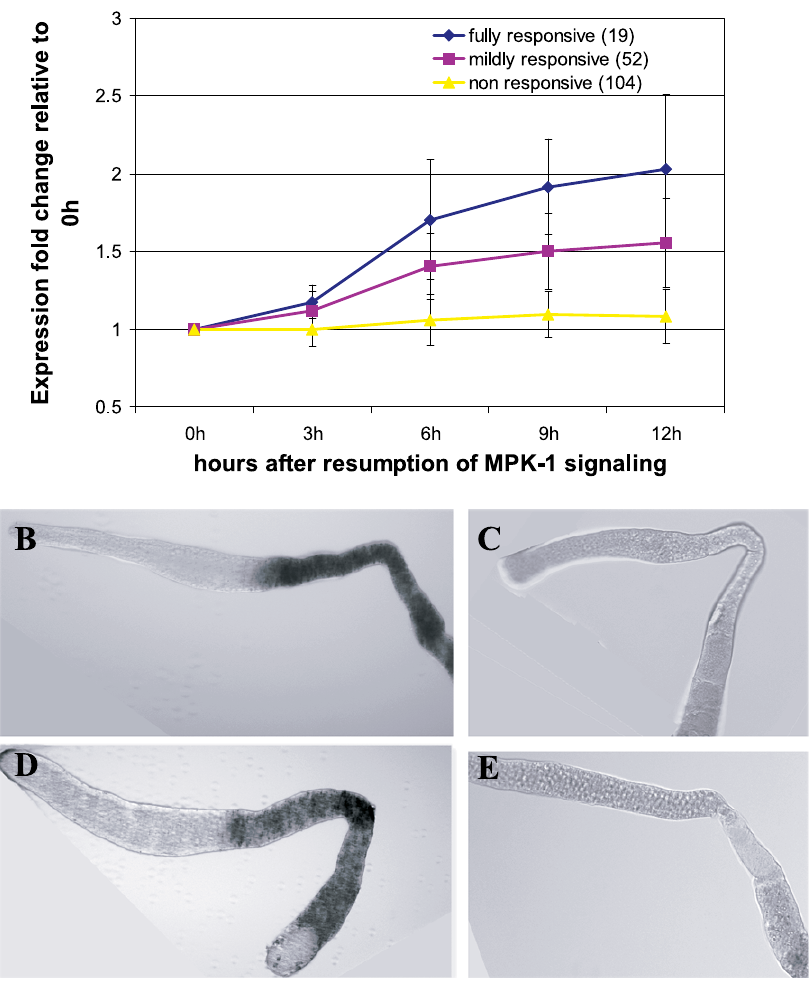
Figure 5. X-Linked Genes Depend on MPK-1 for Germ Line Expression (A) Graph of mean changes in gene expression for X-linked genes in response to MPK-1 signaling. Blue indicates 19 MPK-1 signaling-responsive genes; pink indicates 52 additional X-linked genes with a mild response; and yellow indicates 104 X-linked genes with no response. Error bars indicate standard deviation. (B–E) In situ hybridization of N2 (A and C) and mpk-1 (B and D) gonads with probes for an X-linked MPK-1 signaling-responsive gene, F35C8.7 (A and B), and an X-linked non-responsive gene, C04A11.3 (C and D). Sense probes showed no